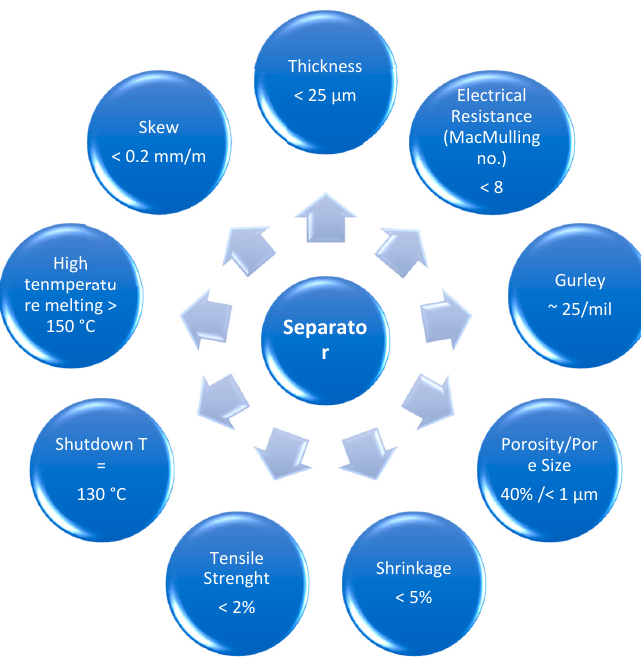
Figure 2. Ideal values for the main requirements of a separator membrane.